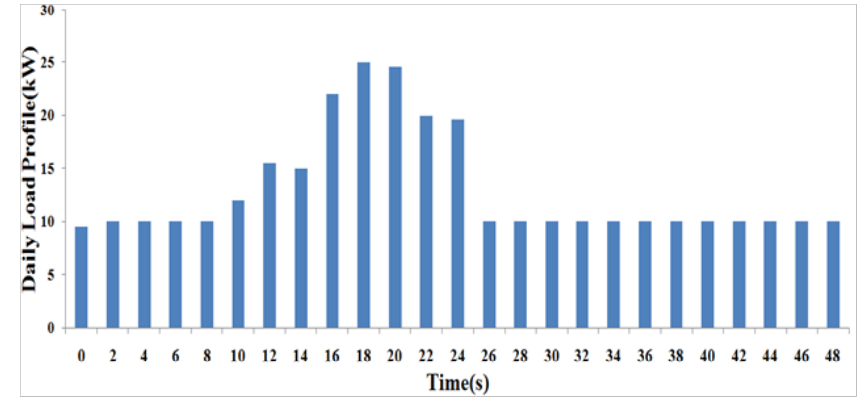
Figure 1. Typical load profile of a mobile